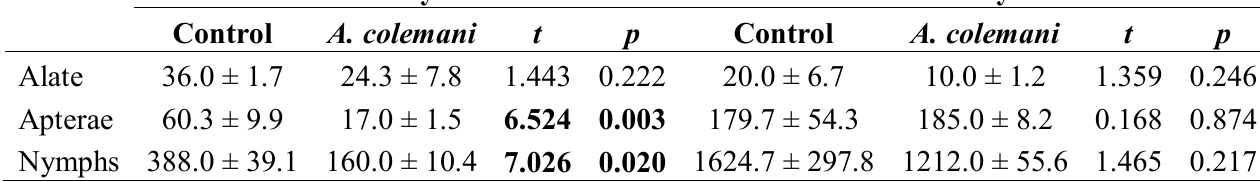
Table 4. Mean ± S.E. density (no. of individuals/plant) of adult morphs and nymphs in the CABYV-infected source plant at 7 and 14 days in cages with and without (control) A. colemani . Means in the same row followed by statistics in bold are significantly different according to Student’s t test ( p <